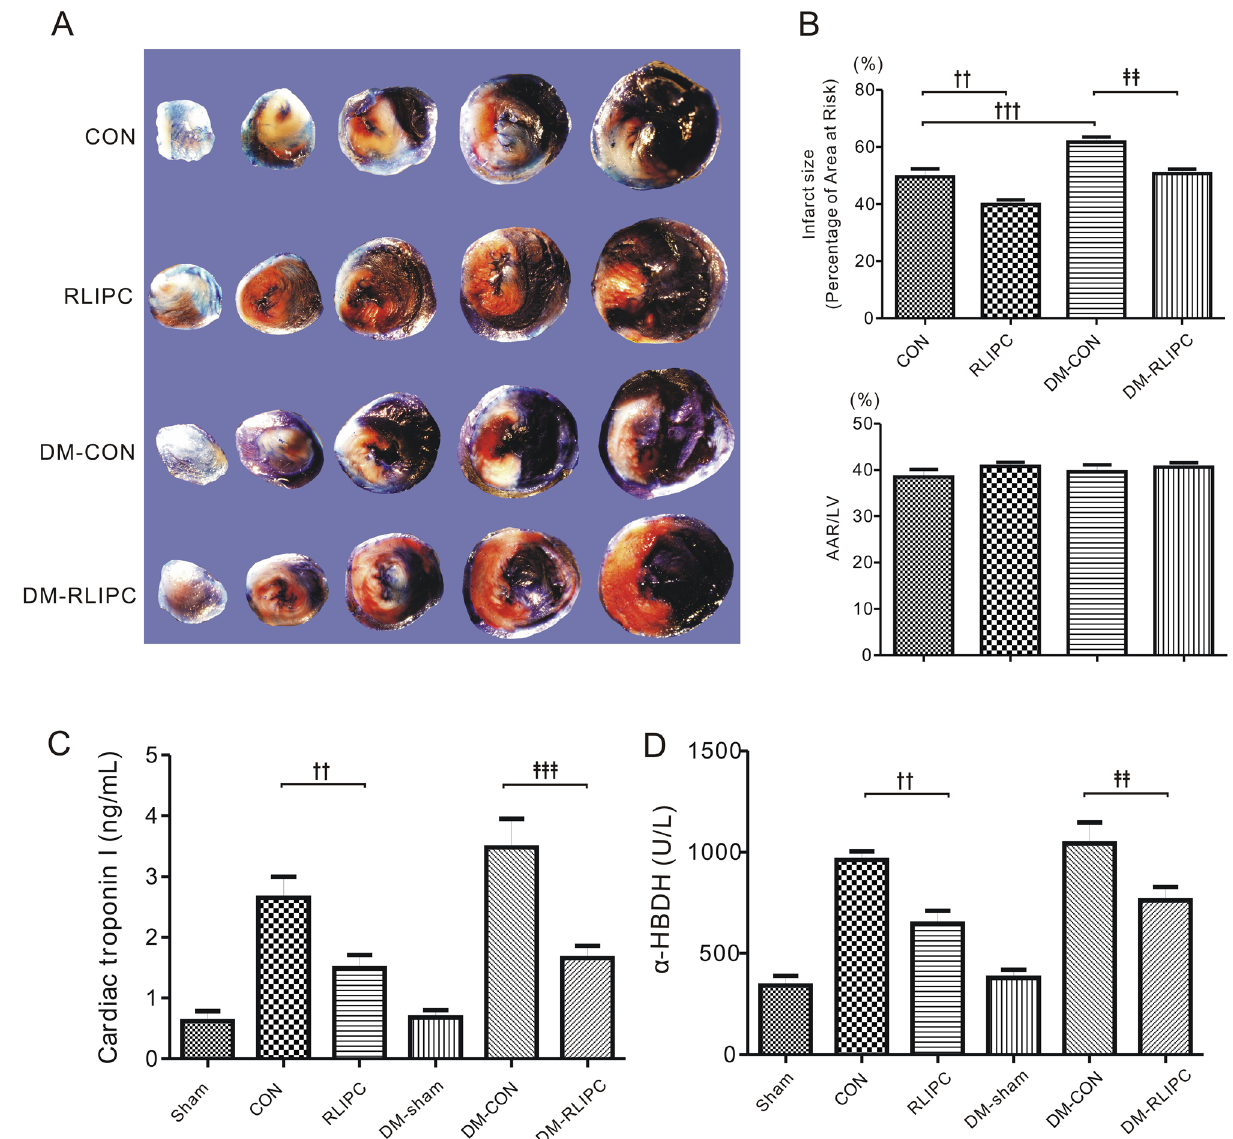
Figure 4. Remote ischemic preconditioning alleviated myocardial infarction. ( A ) Representative sections of triphenyltetrazolium chloride (TTC)-stained heart subjected to 45 min myocardial ischemia followed by 3 h of reperfusion. Sham, sham surgery; CON, LAD ligation; RLIPC, remote liver ischemic preconditioning; DM: diabetic rats. ( B ) Quantification of myocardial infarct size expressed as a percentage of left ventricular (LV) area at risk (AAR) (top) and AAR expressed as a percentage of LV area (bottom). Data were presented as mean ± SEM; n = 6–7 each group. †† p < 0.01 and ††† p < 0.001 compared with CON; and ‡‡ p < 0.01 compared with DM-CON (by one-way ANOVA). ( C ) Post-reperfusion injury mean serum levels of cardiac troponin I (cTnI) in rats subjected to 45 min of left anterior descending artery occlusion followed by 3 h of reperfusion. n = 6–8 each group. †† p < 0.01 compared with CON; and ‡‡‡ p < 0.001 compared with DM-CON (by one-way ANOVA). ( D